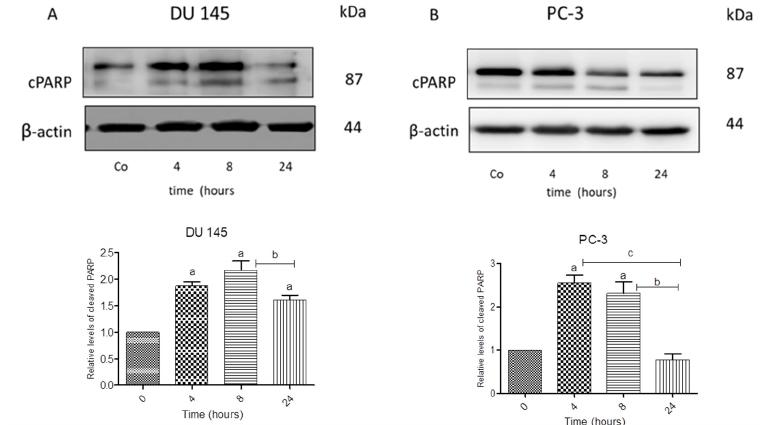
Figure 5. Western blot analysis of cleaved PARP in DU 145 ( A ) and PC-3 cells ( B ) treated with 40 μ M N -allyl-BS for indicated time points. β -actin was used as a lane loading control. The results are presented as mean ± SE of three independent experiments. The statistical significance of differences between respective samples was determined by one-way ANOVA followed by Bonferroni’s multiple comparison test, where ( A ) indicates significant difference between control and treated cells P < 0.05 and (b, c) indicates significant di ff erence between 4, 8, and 24 h of 40 µ M N -allyl-BS-treated cells P <